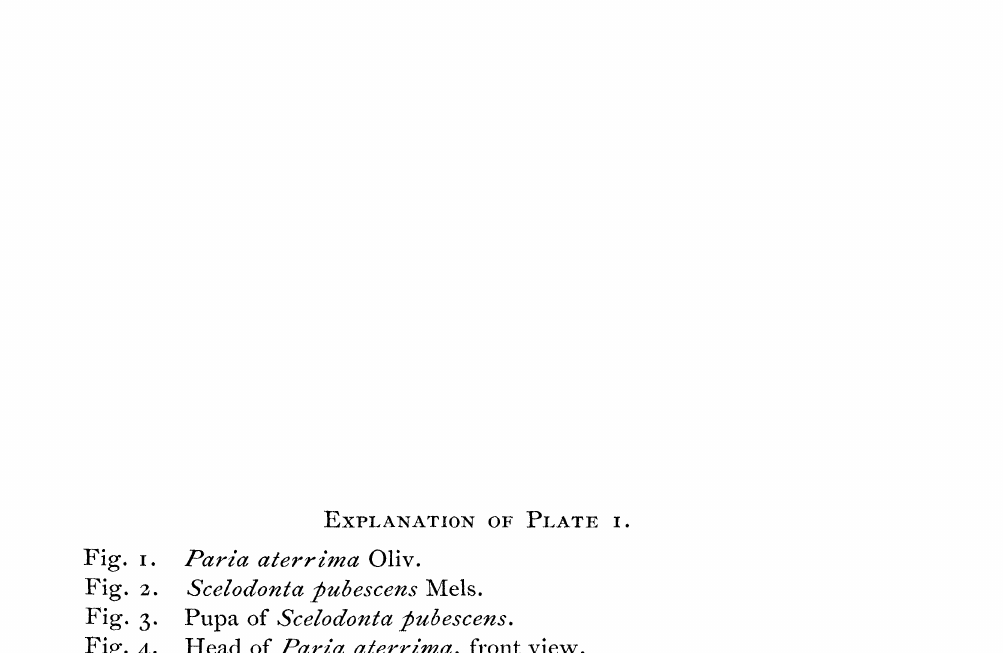
EXPLANATION OF PLATE I. Paria alerr ima Oliv. Scelodonta puSescens